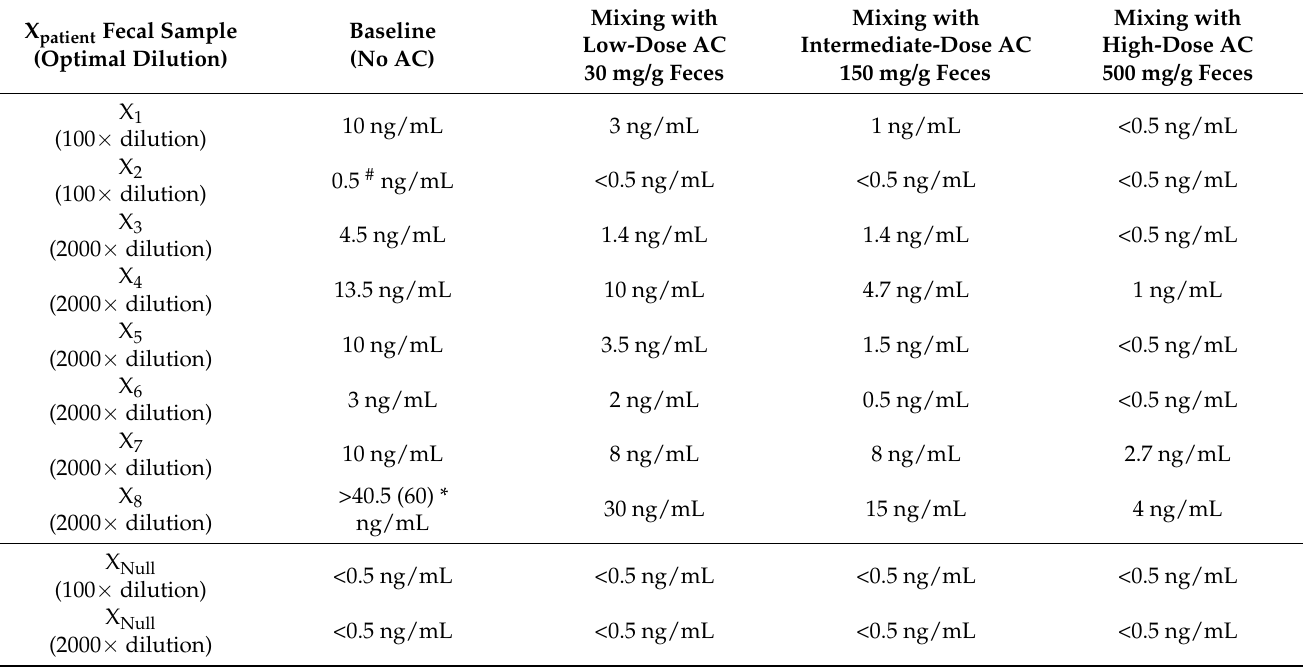
Table 2. Fecal ceftriaxone levels (ng/mL) of all ‘X X ’ samples at their optimal dilution.